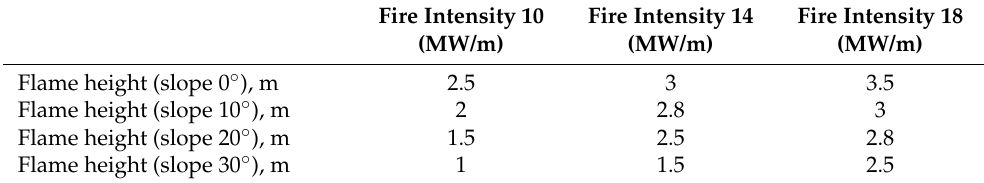
Table 1. Comparison of the flame height for different terrain slopes and fire